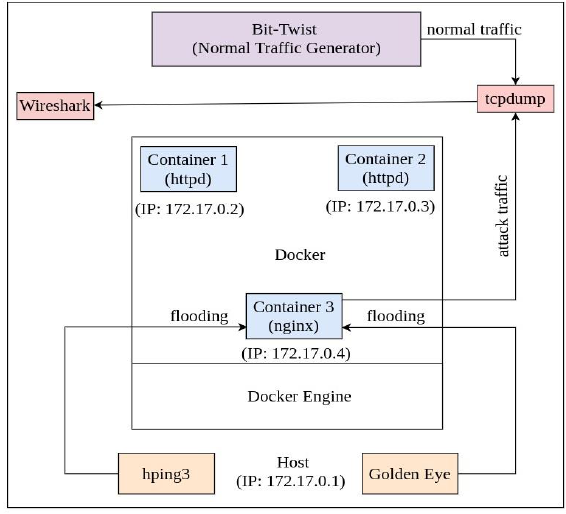
Figure 1. The testbed environment for dos attack.